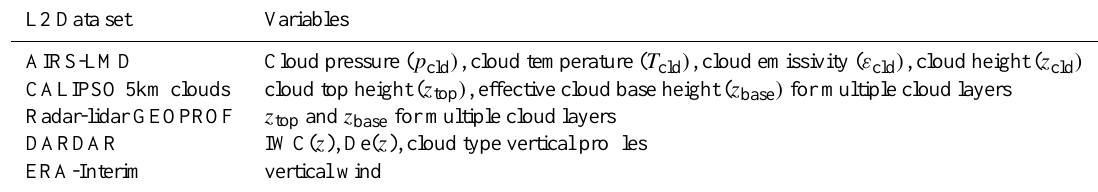
Table 1. L2 data sets and products used in this